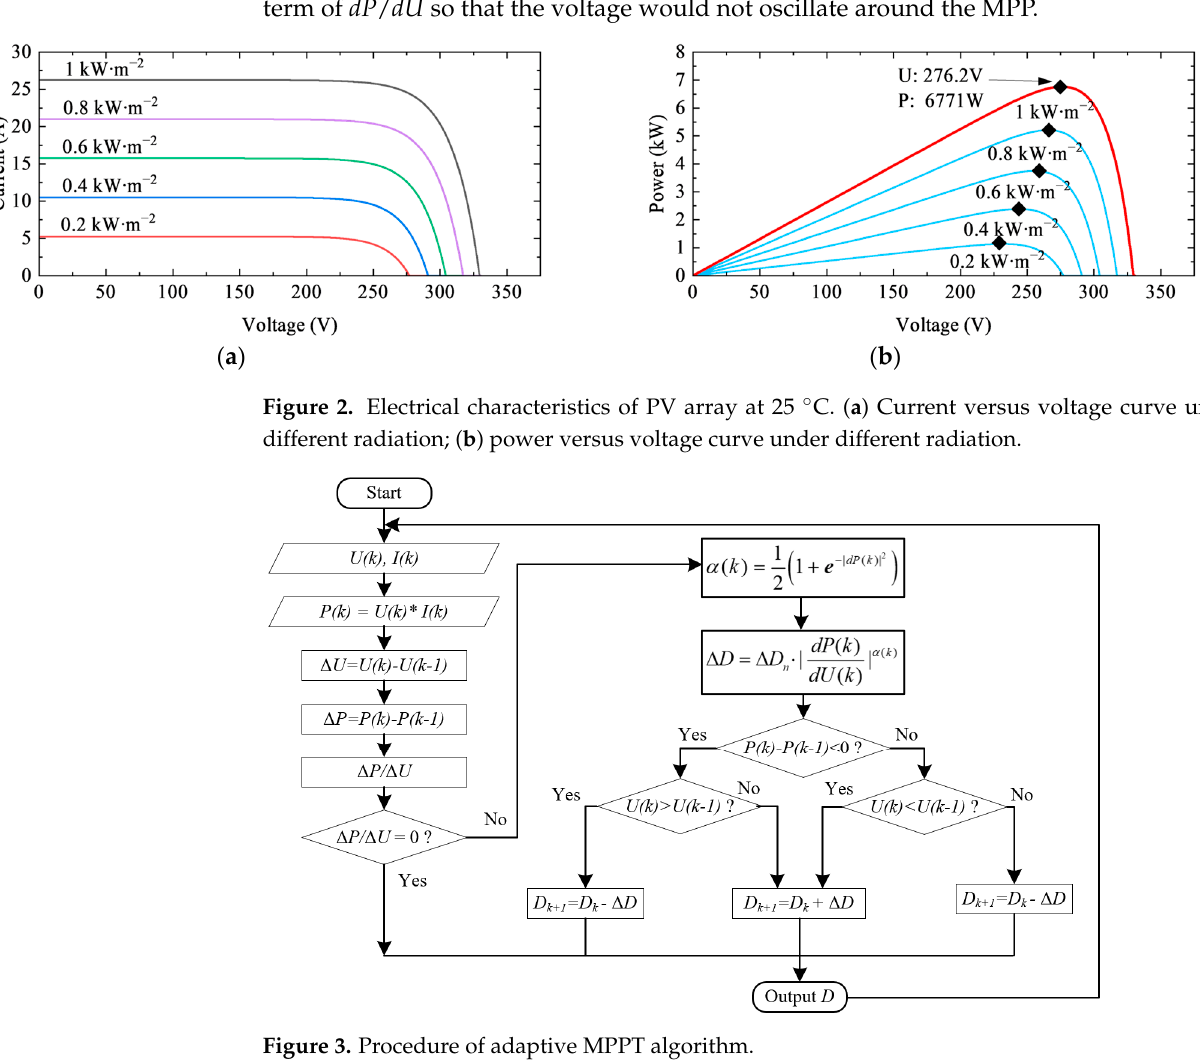
Figure 3. Procedure of adaptive MPPT algorithm.